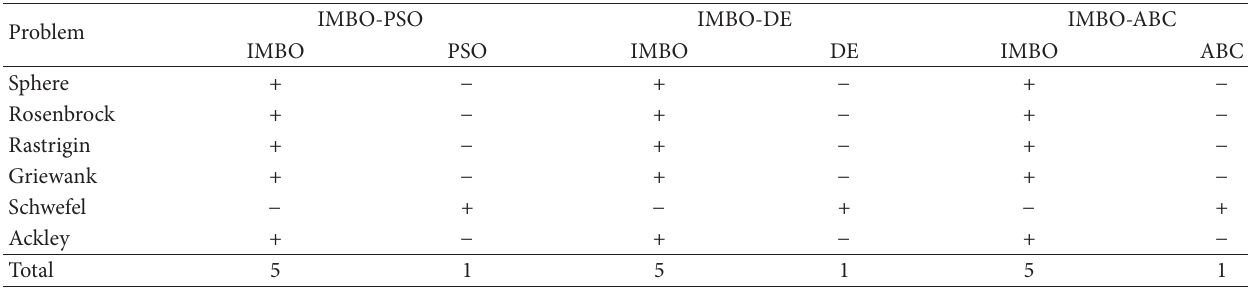
Table 14: Comparative results of IMBO with DE, PSO, and ABC algorithms over 30 independent runs for genotype size 1000. + indicates that the algorithm is better while − indicates that it is worse than the other. If both algorithms show similar performance, they are both +.